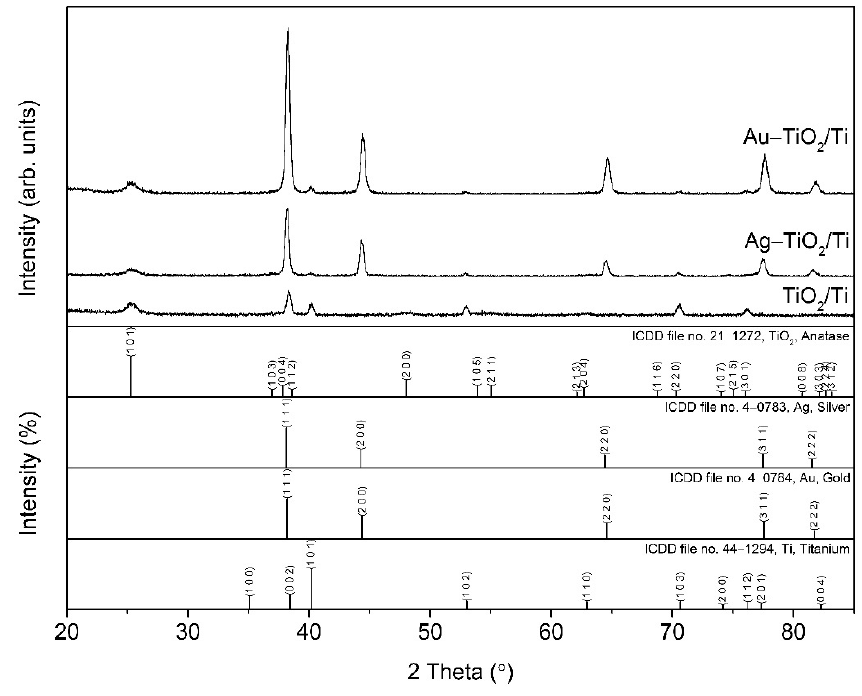
Figure 4. XRD diffractograms of the investigated samples: Au–TiO 2 /Ti, Ag–TiO 2 /Ti, TiO 2 /Ti.